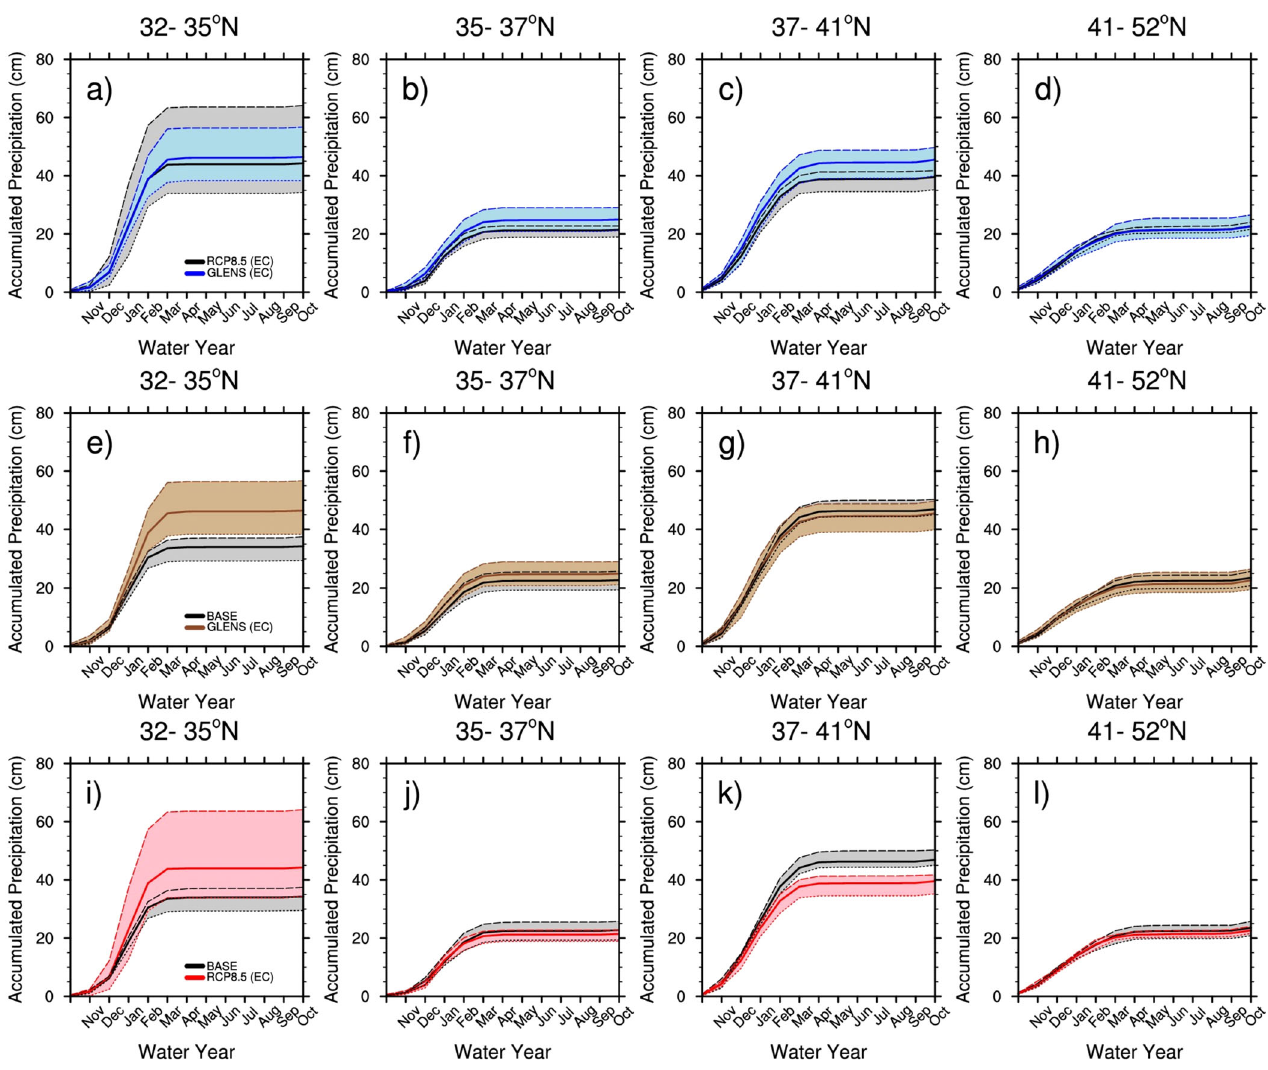
Fig. 6 Water year estimates for Pineapple Express ARs. Mean water year and ensemble range (x-axis, mmday − 1 ) for accumulated Pineapple Express AR-precipitation amount (cm) for GLENS end of century (EC) (blue/light blue) compared to RCP8.5 (EC) (black/gray) ( a – d ), GLENS (EC) (brown/tan) compared to BASE (black/gray) ( e – h ), RCP8.5 (EC) (red/pink) compared to BASE (black/gray) ( i – l ). Color organization for scenario comparisons and precipitation area means are the same as for Fig.